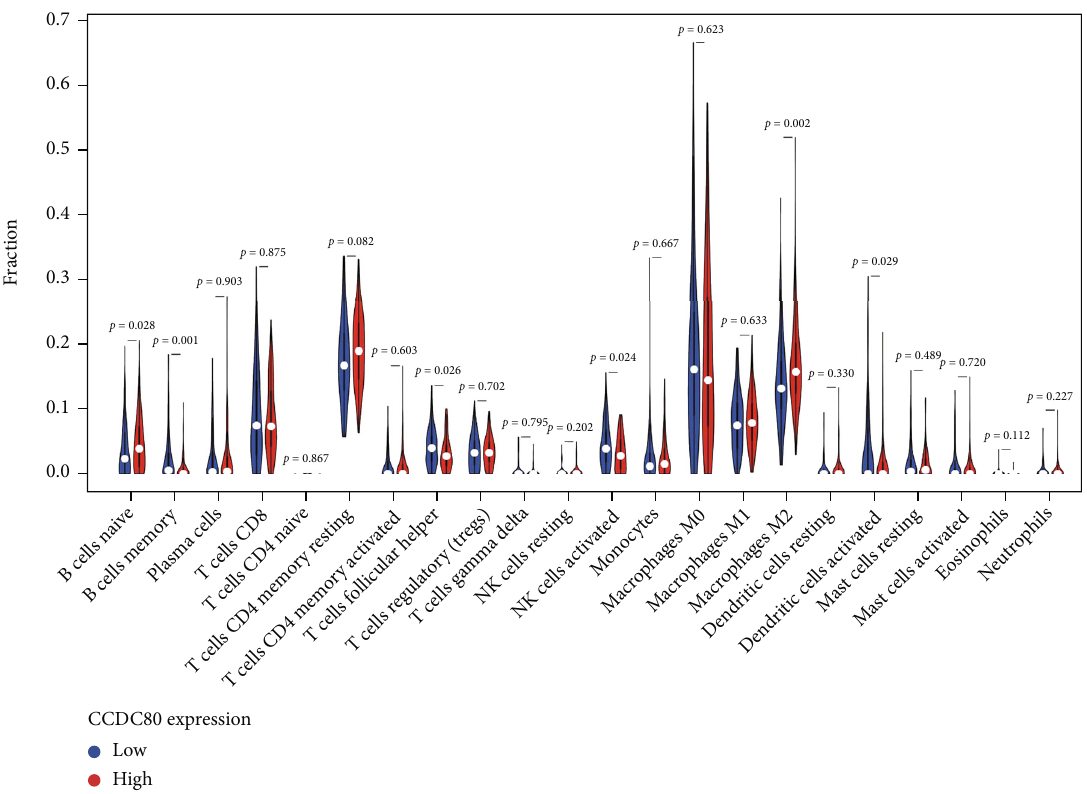
Figure 5: The relationship between CCDC80 expression and the fraction of immune cell in fi ltration in OVCA based on CIBERSORT